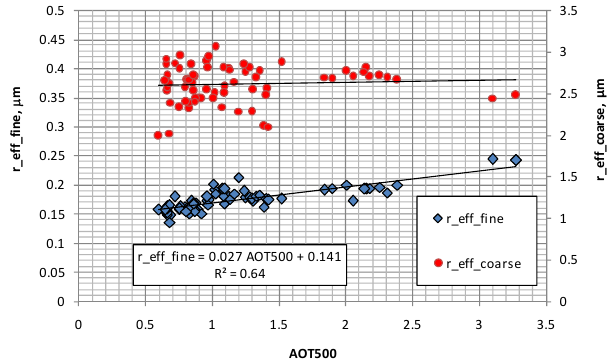
Fig. 7. Changes in effective radii of fine (left axis) and coarse (right Fig.7. Changes in effective radii of fine (left axis) and coarse (right axis) aerosol modes versus aerosol content (AOT500) during the fire conditions. The regression equation is axis) aerosol modes versus aerosol content (AOT500) during the fire given for fine mode particles. conditions. The regression equation is given for fine mode